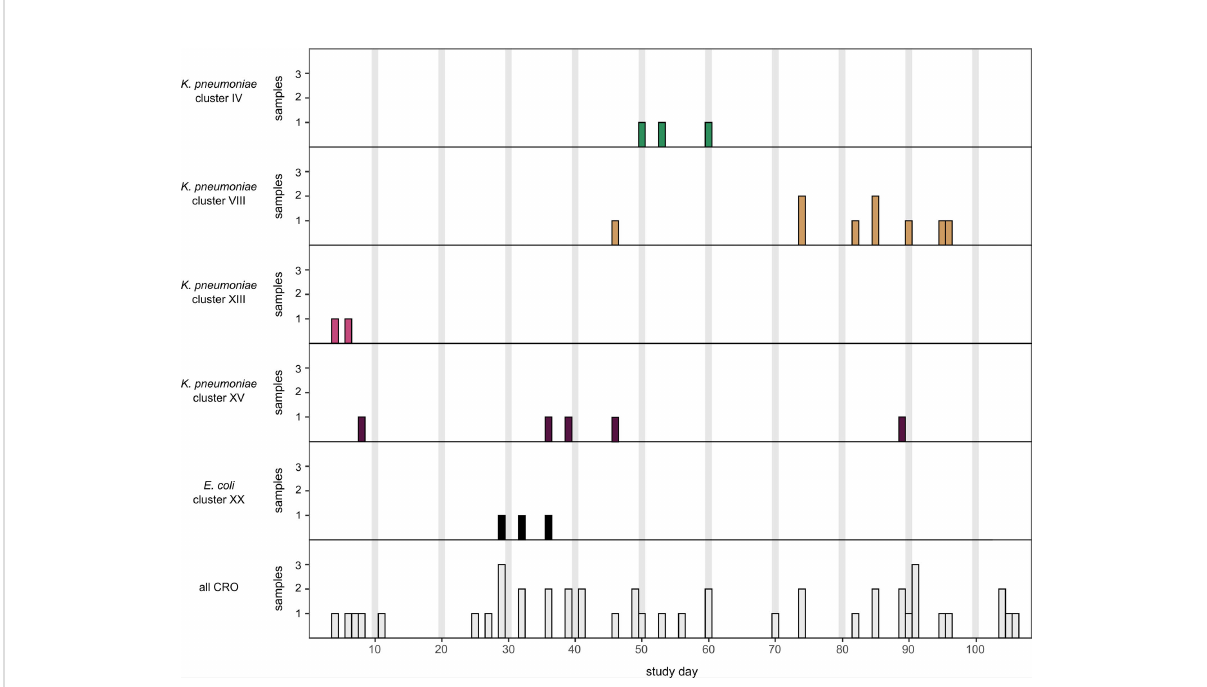
FIGURE 3 Surveillance timeline of CRO over 110 study days. From 51 detected CRO, seven copy strains were excluded resulting in 44 unique isolates. In separate rows, the K. pneumoniae clusters IV, VIII, XIII, XV and the E. coli cluster XX are